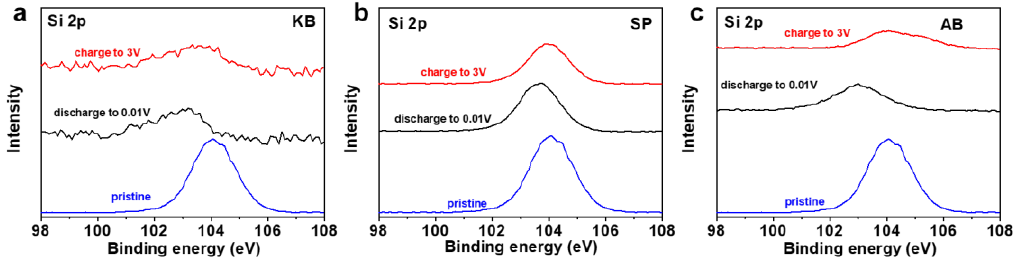
Figure 6. Si 2p XPS spectra of SiO 2 anode with KB ( a ), SP ( b ) and AB ( c ) at different